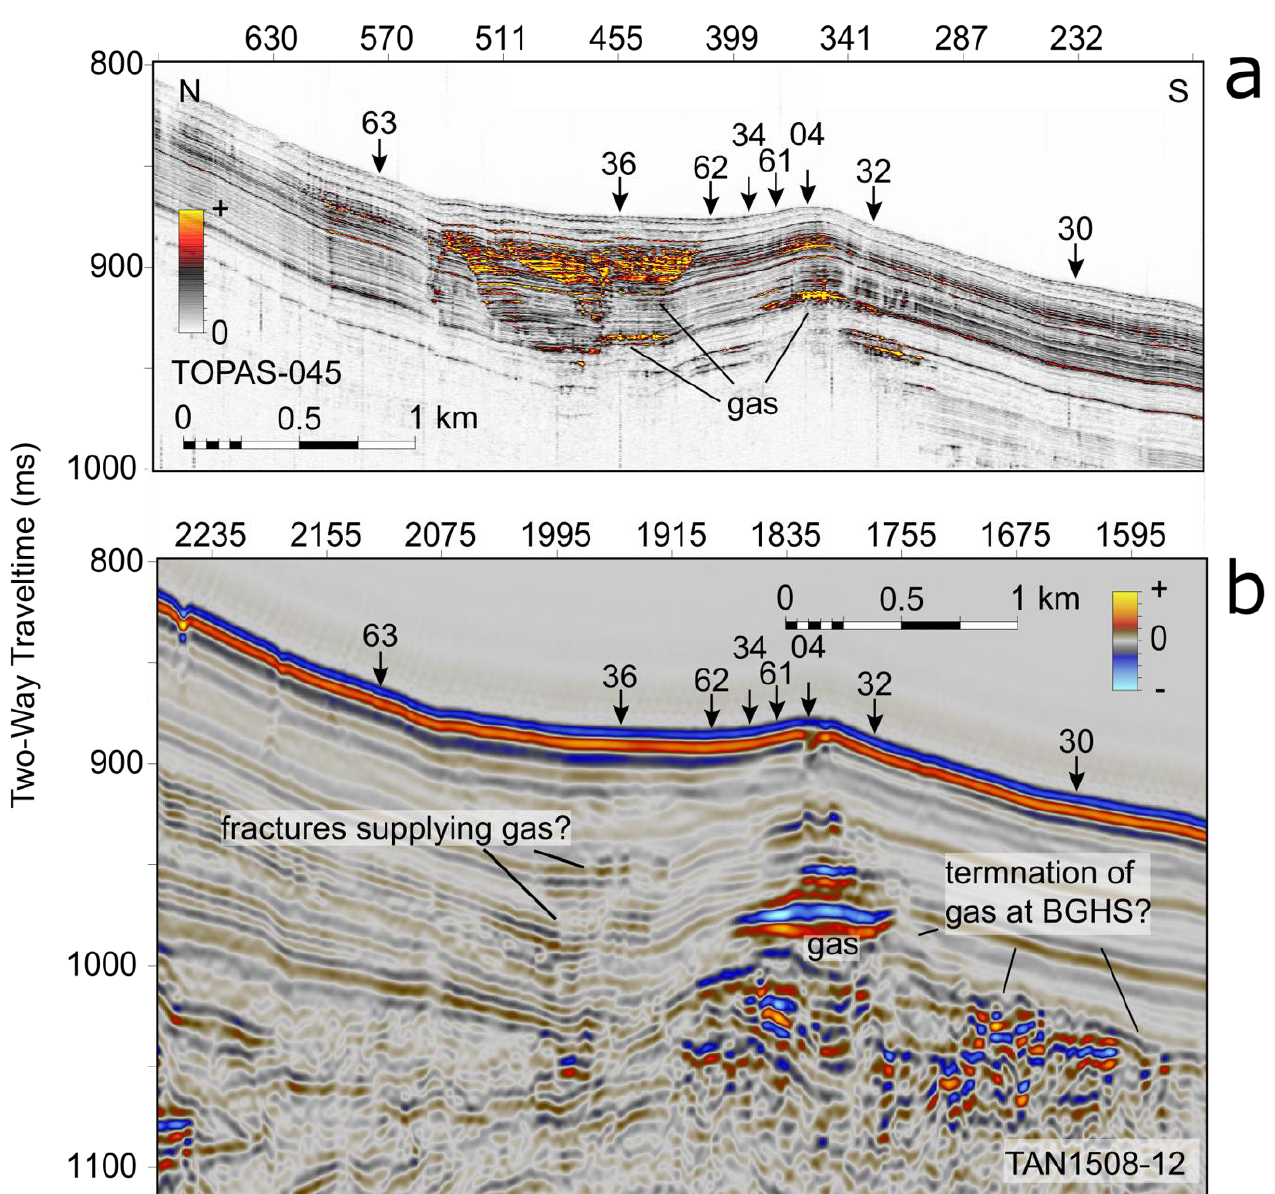
Figure 4. ( a ) TOPAS data from Mahia Transect 1; see Figure 1b for geographical location. Numbered black arrows are piston core sites. Highly reflective regions interpreted as free gas (labeled). ( b ) Seismic data from the same location as the TOPAS data above. Horizontal and vertical scales are the same as those used for the TOPAS data. The possible base of gas hydrate stability (BGHS) is interpreted as the upper termination of strong reflectivity.